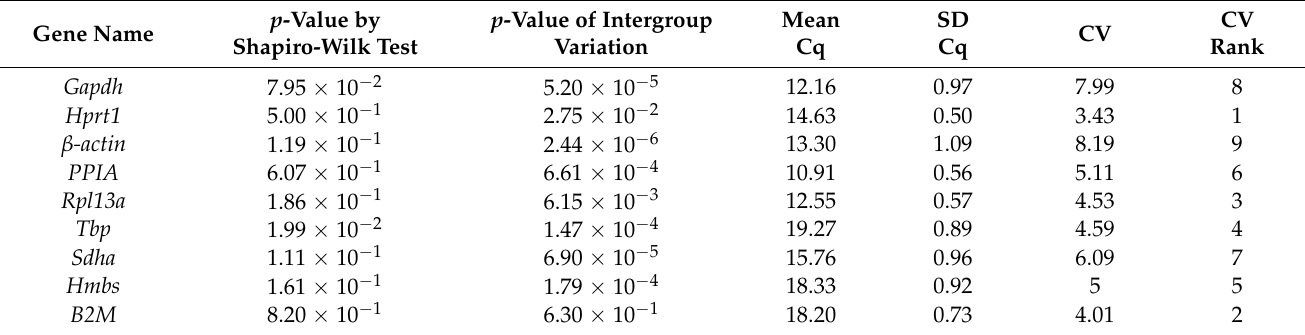
Table 5. Expression features in male hypothalamus tissues at different developmental stages analyzed by SPSS.